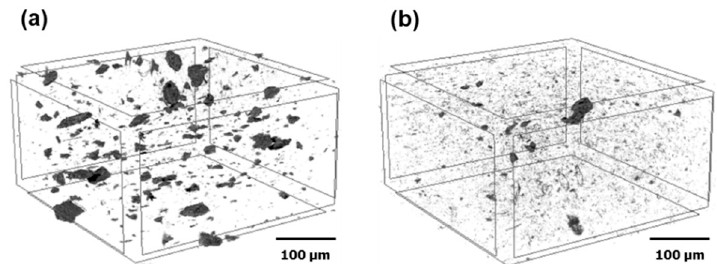
Figure 5. Three dimensional non-destructive X-ray micro-computed tomography (3D micro-CT) images of ( a ) PP/RGO and ( b ) PP/FGO_12 composites.